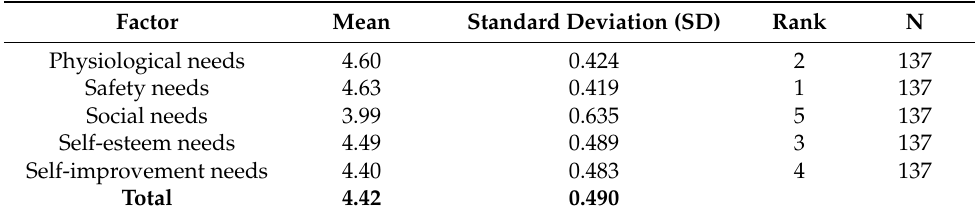
Table 1. Mean, SD, and Rank for Maslow Hierarchy of Needs. Factor Mean Standard Deviation (SD) Rank N Physiological needs 4.60 0.424 2 137 Safety needs 4.63 0.419 1 137 Social needs 3.99 0.635 5 137 Self-esteem needs 4.49 0.489 3 137 Self-improvement needs 4.40 0.483 4 137 Total 4.42